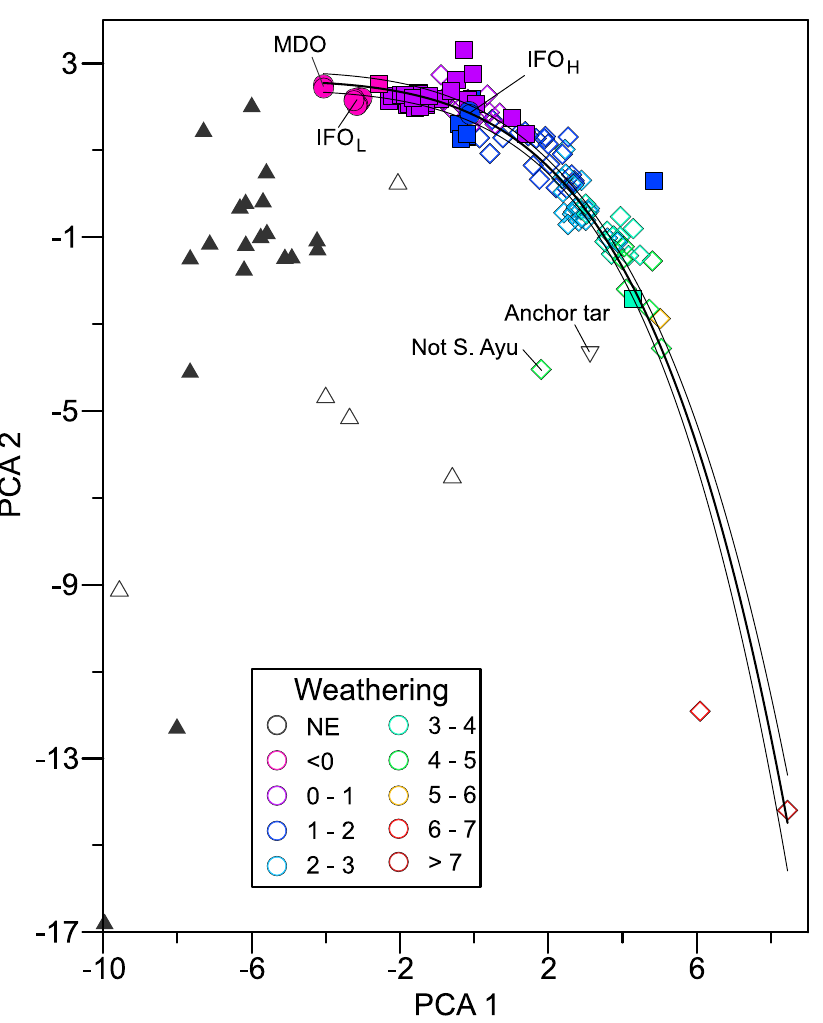
Fig 3. Discrimination of PAHs in reference and oiled samples by principal component analysis. S . Ayu source oil is illustrated with solid circles. Source oil types were marine diesel oil (MDO), intermediate fuel oil light (IFO L ), and intermediate fuel oil heavy (IFO H ). Solid squares indicate oil from sediment in 2004 – 2005 and open diamonds indicate oil from 2008 sediment. Black triangles indicate non-oiled reference samples and open triangles represent 2008 data; weathering was not estimated (NE) in these. Anchor tar from an unknown origin is also included for comparison. One sample with hydrocarbons from the oiled area was not verified as S . Ayu oil (annotated). Percent total chrysenes in oiled samples is indicated by color; small values indicate the least weathered samples, large values indicate the most weathering. The first component (PCA 1) explained 28% of the variance and the second (PCA 2) explained 21% of the